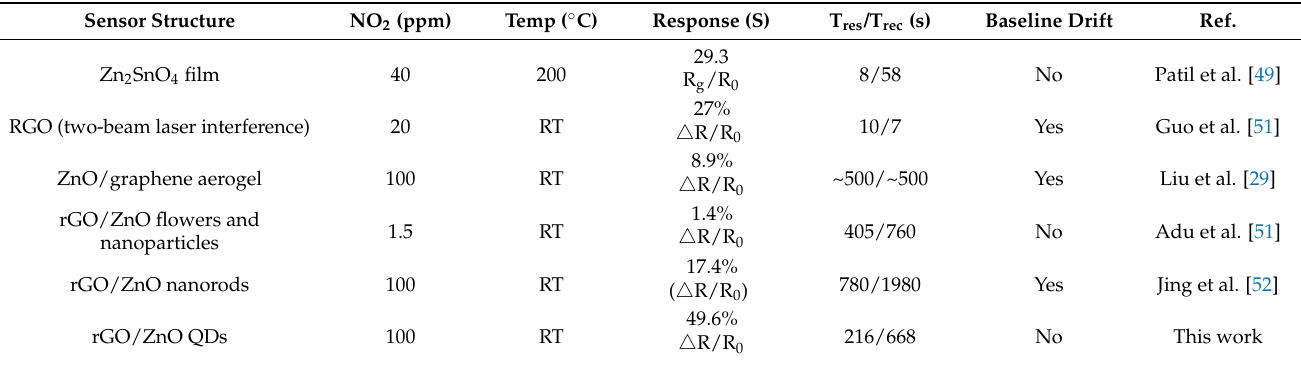
Table 1. Comparison between the sensing performance of our NO 2 sensor and that of other reported gas sensors.